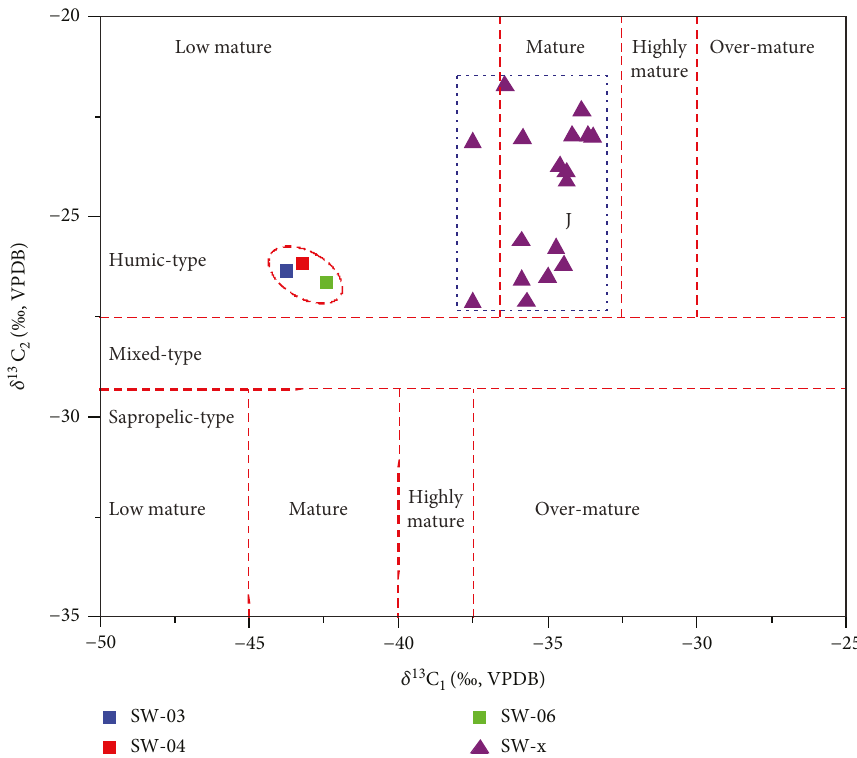
Figure 12: Plots of δ 13 C (ethane) vs. δ 13 C (methane) for gas seeps in the Junggar Basin. Note: the dataset SW-x is from Sun et al. [77] and 2 1 represents subsurface reservoir samples. The boundary lines for di ff erent genetic and maturation groups are modi fi ed after Dai [78] and Tao et al. [34]. Please see Tao et al. [34] for the discussion and de fi nition of the boundaries for